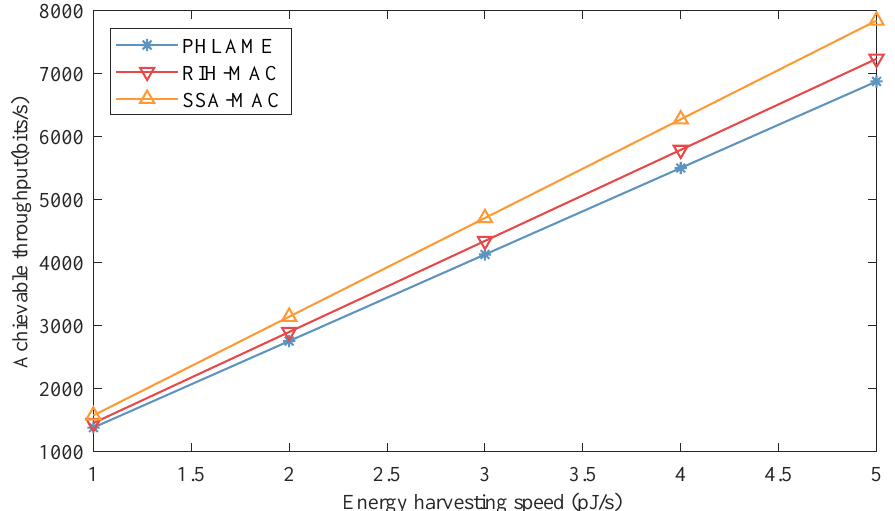
Figure 13. Achievable throughput of different MAC protocols as a function of energy harvesting speed in distributed